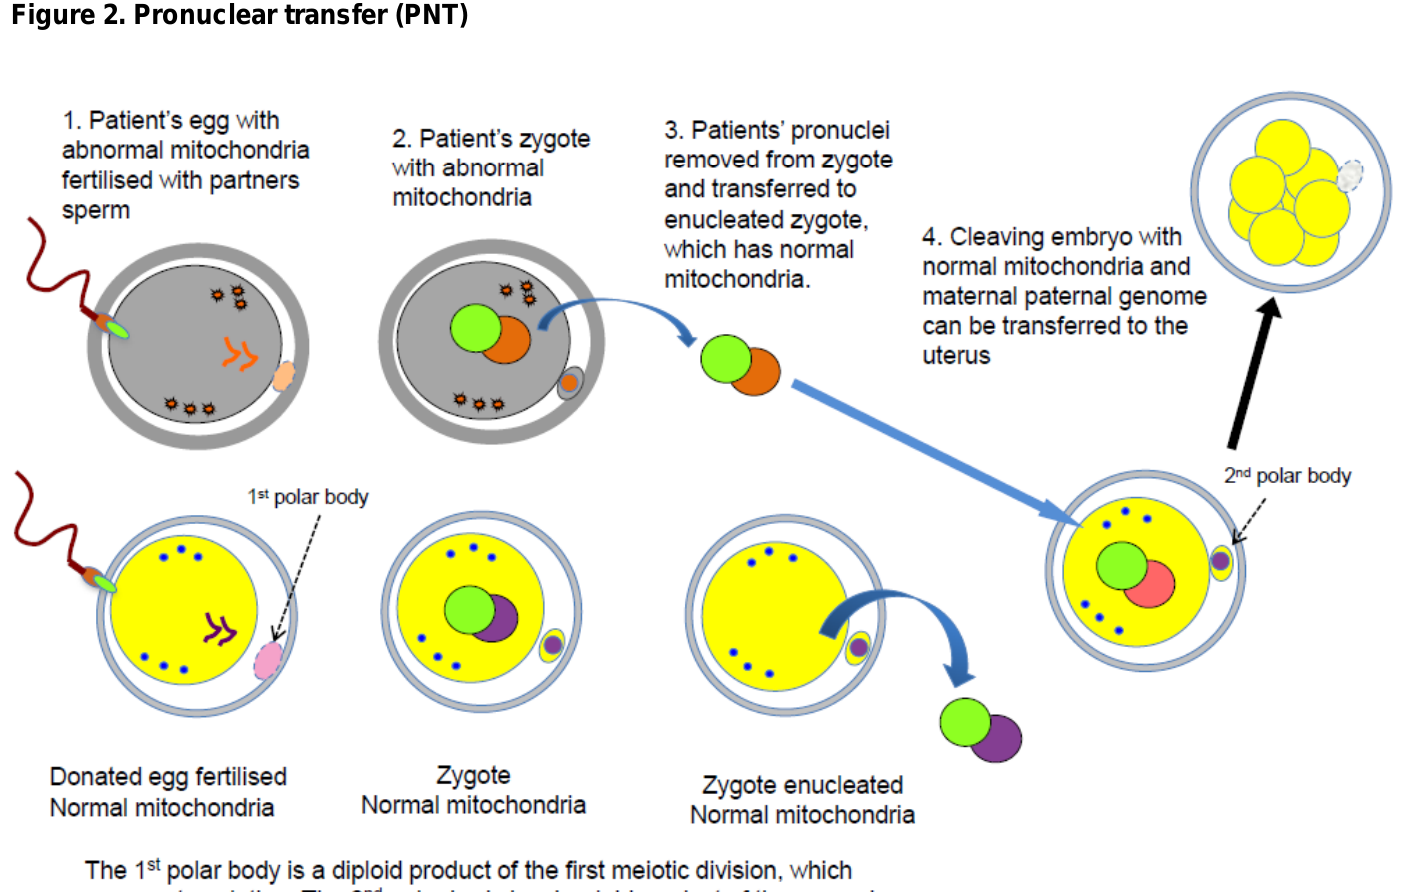
Figure 2. Pronuclear transfer